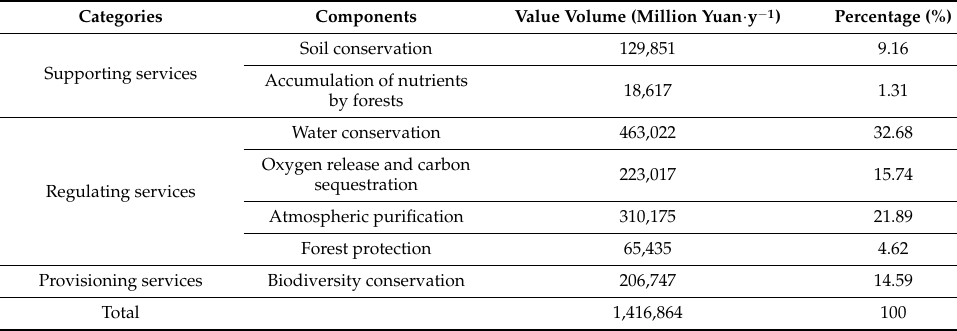
Table 4. National ecological benefits of the CFFG project in